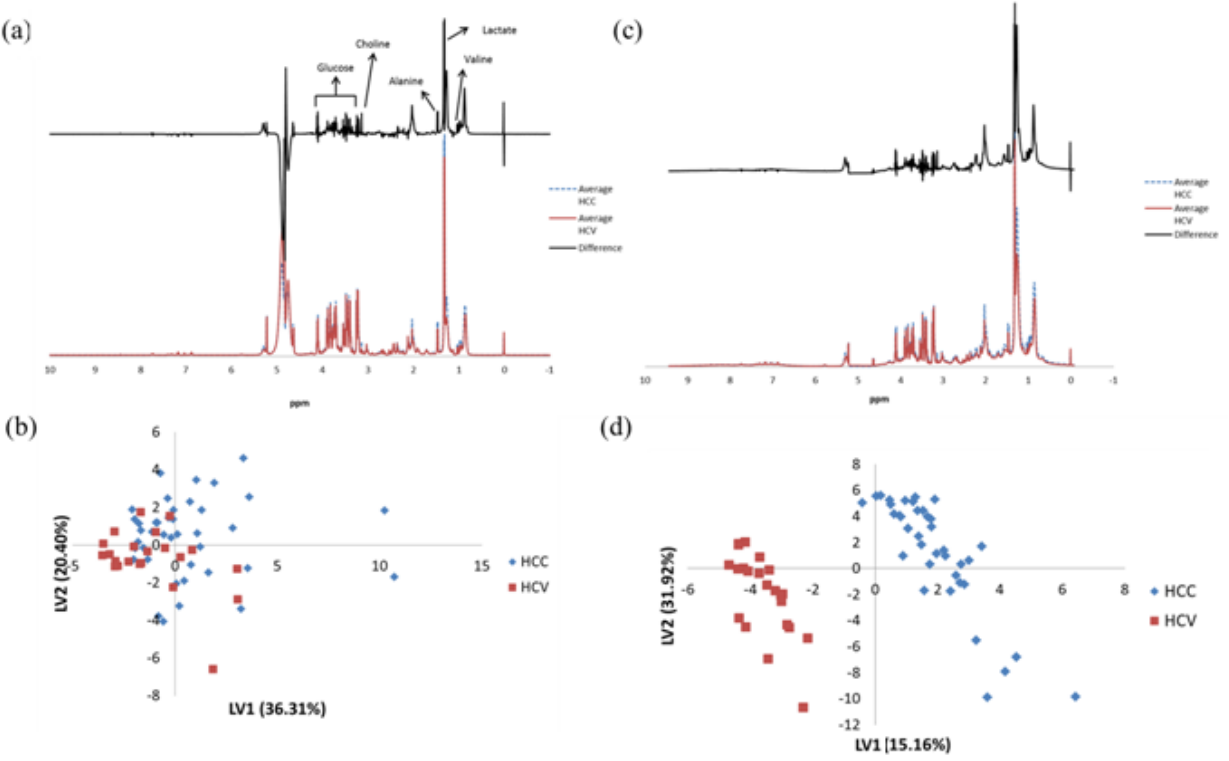
Figure 1. (a) The averaged Carr-Purcell-Meiboom-Gill (CPMG) spectra (bottom) for the HCC patients (blue dashed line, n=40) and HCV patients (red solid line n=22), along with the difference spectrum (top, black solid line). Major differences in metabolites are indicated in the difference spectrum. ( b ) Score plot for the OSC-PLS analysis of the 1 H CPMG NMR spectra for all samples. ( c ) and ( d ) are the same as ( a ) and ( b ) except that they pertain to NOESY